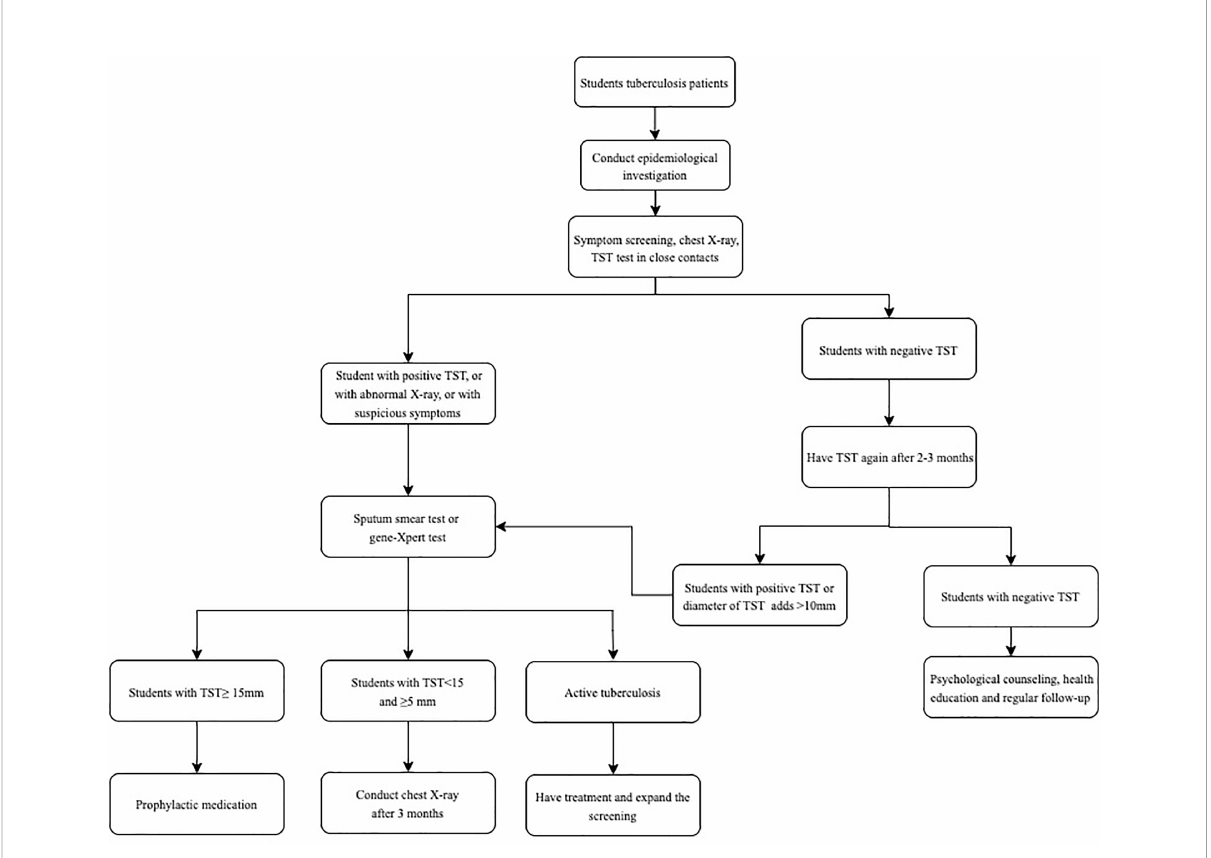
FIGURE 1 Flowchart of a tuberculosis outbreak in a school dispose. TST, tuberculin skin